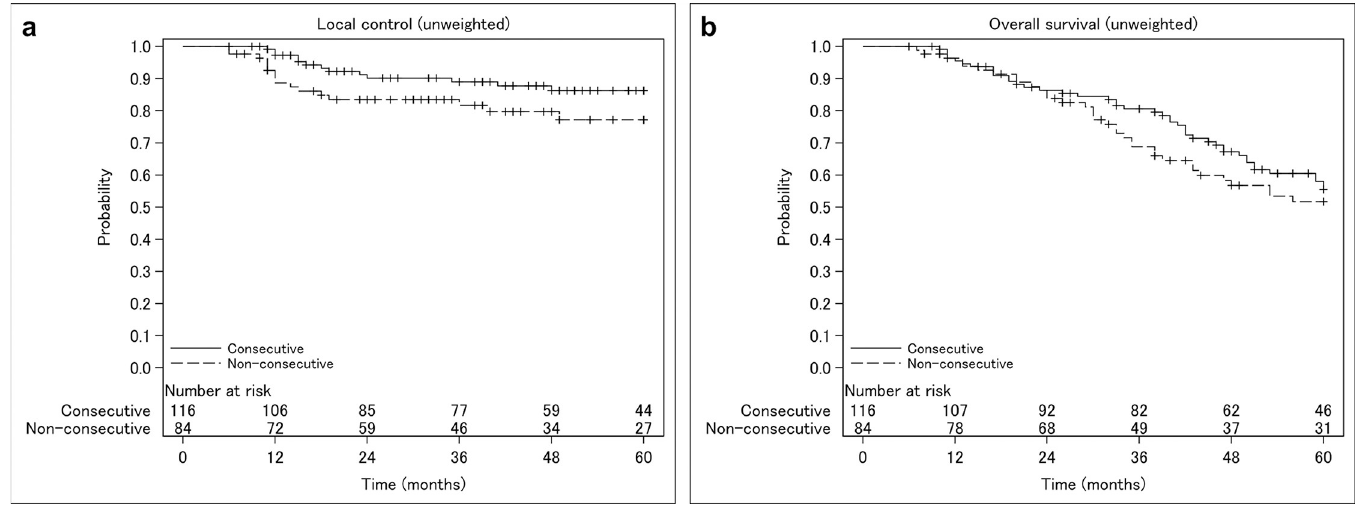
Fig 2. Kaplan–Meier curves of unweighted local control (a) and overall survival (b) in the treatment groups.